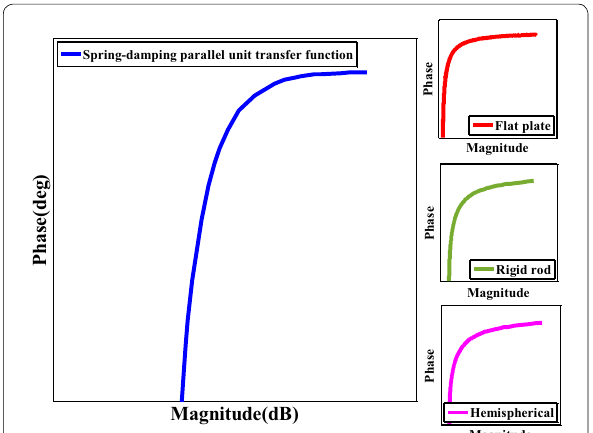
Figure 2 Magnitude-Phase-angle characteristics of the battery under mechanical abuse conditions in frequency domain